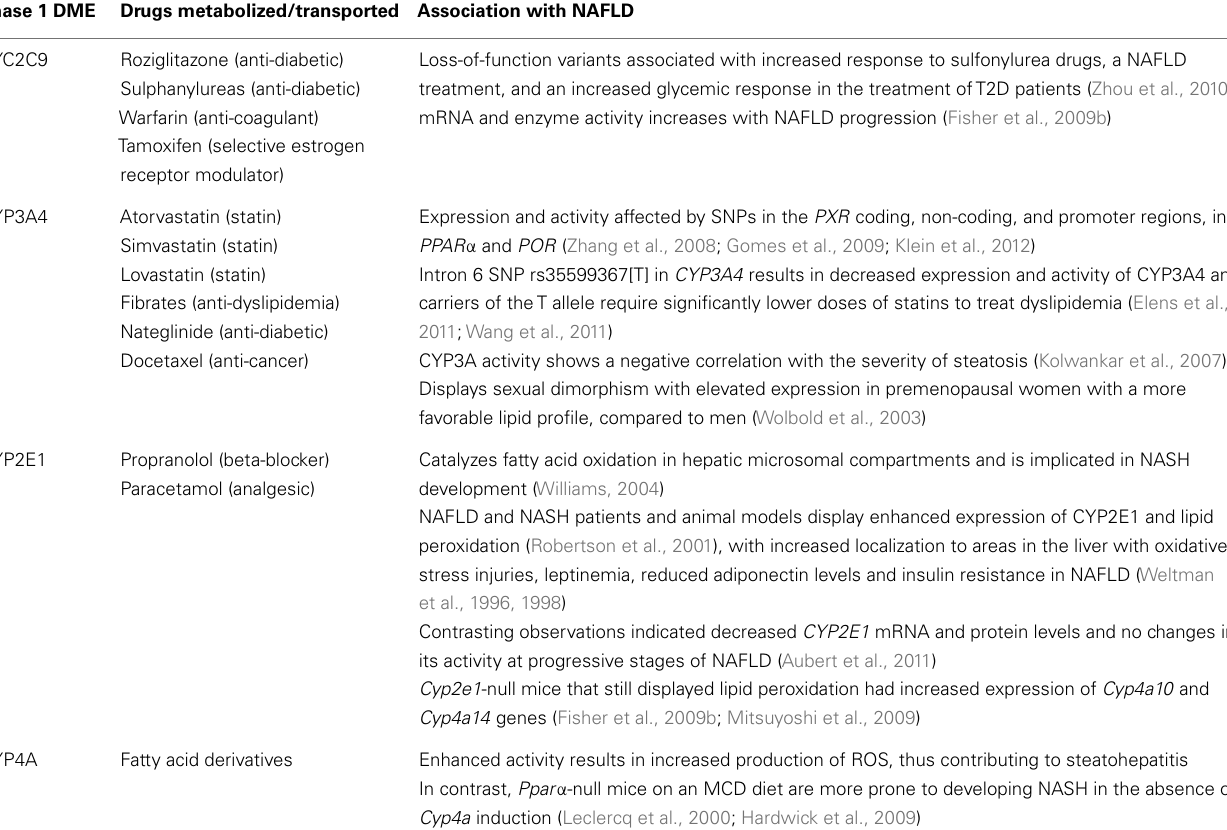
Table 2 | Phase I drug metabolizing enzymes implicated in the pathogenesis of NAFLD. Phase 1 DME Drugs metabolized/transported Association with